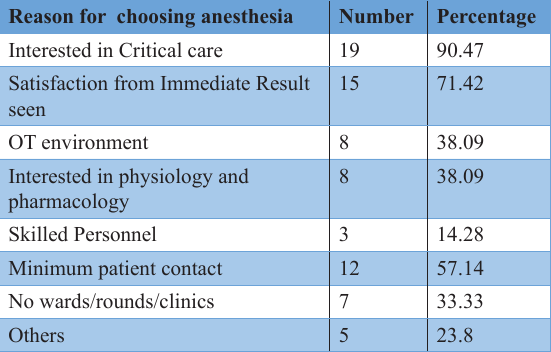
Table 2. Reasons for choosing Anesthesia